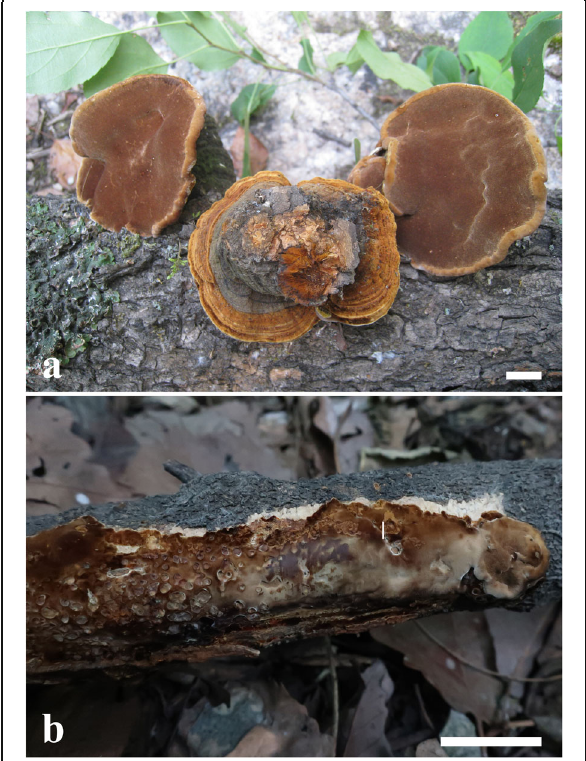
Fig. 3 Basidiomes of Sanghuangporus subbaumii in situ. a Dai 13360 (holotype). b LWZ 20190722 – 18 (paratype). Bars: 2